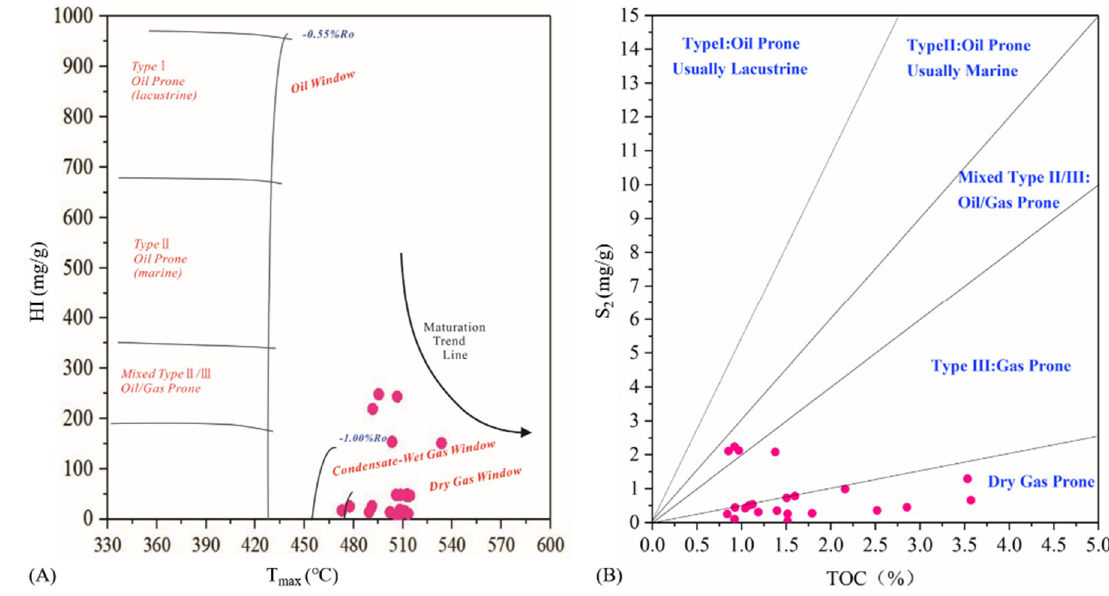
Figure 2. Cross-plots of T max versus hydrogen index ( A ) and S 2 versus total organic carbon ( B ) for identifying the kerogen type of the Shahezi shale in CFD. identifying the kerogen type of the Shahezi shale in